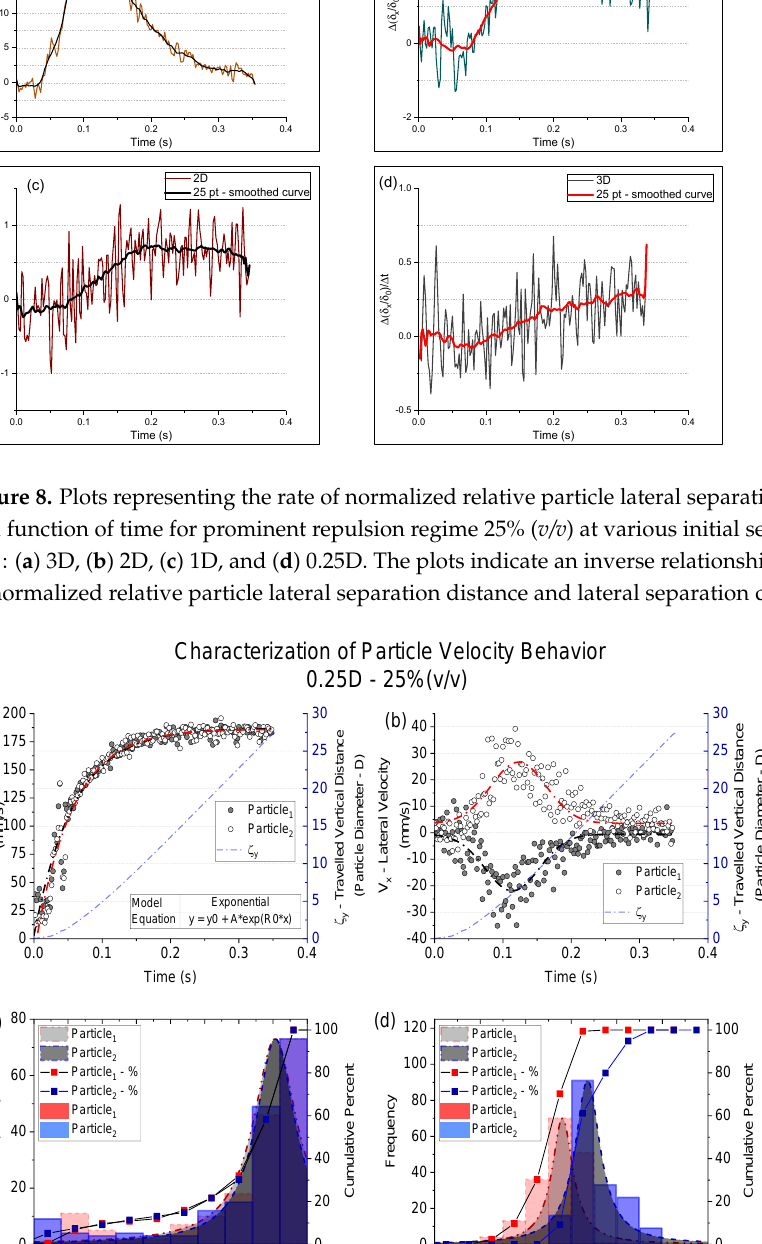
Figure 9. Plots representing an example of particles’ velocity components: ( a ) vertical and ( b ) lateral for 0.25D–25%( v/v ) and their associated histogram distributions ( c , d ). Prominent repulsion is apparent in lateral velocity components.